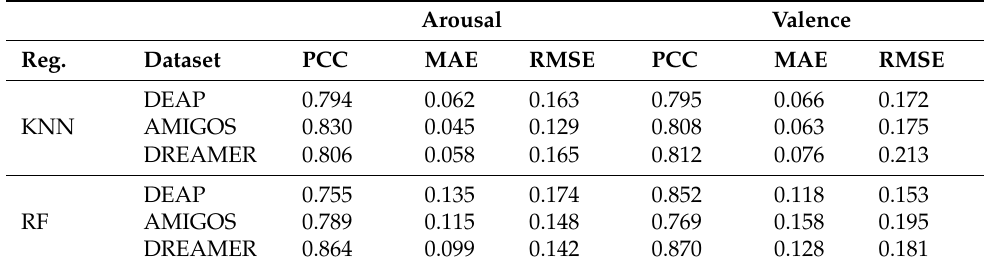
Table 7. Prediction results using the datasets DEAP, AMIGOS and DREAMER.